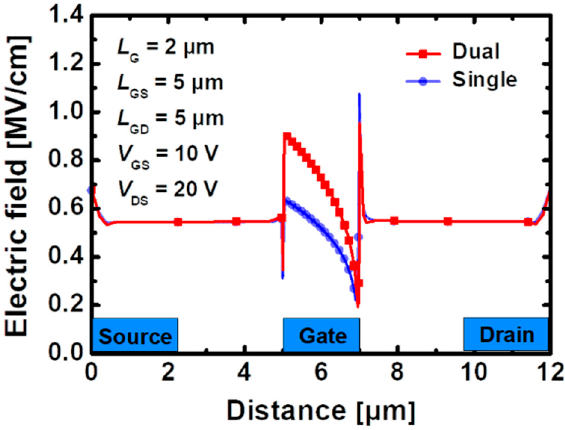
Figure 5. Electric field distribution across the 2-DEG channel layer when self-heating effect is applied in recessed-gate GaN MOSFET using the stacked TiO 2 /Si 3 N 4 dual-layer insulator and Si 3 N 4 single-layer insulator under bias V GS = 10 V, V DS = 20 V.